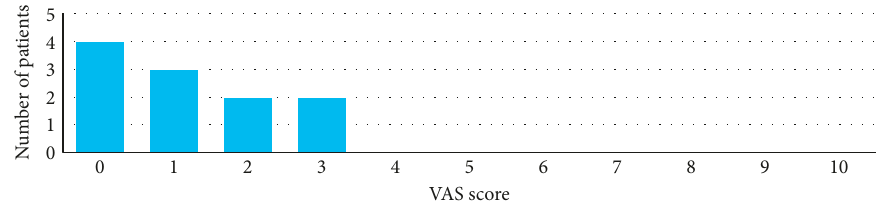
Figure 10: Distribution of the 11 patients by the VAS score after CUSA